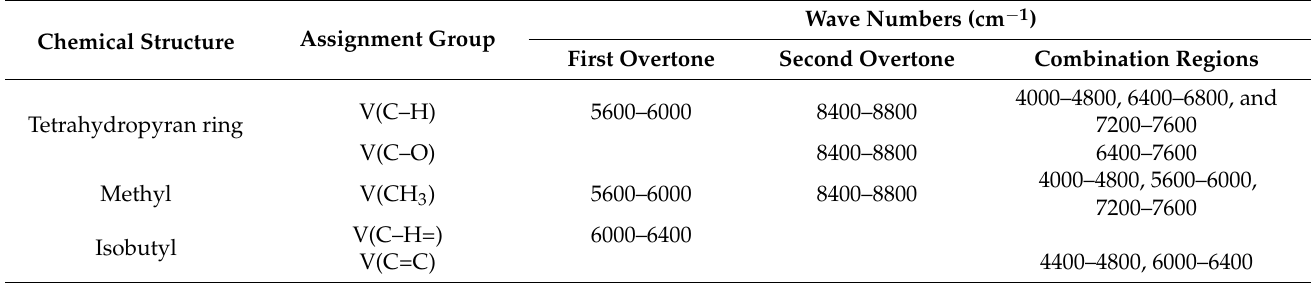
Table 4. Group assignment of different chemical structures in Rose Oxide